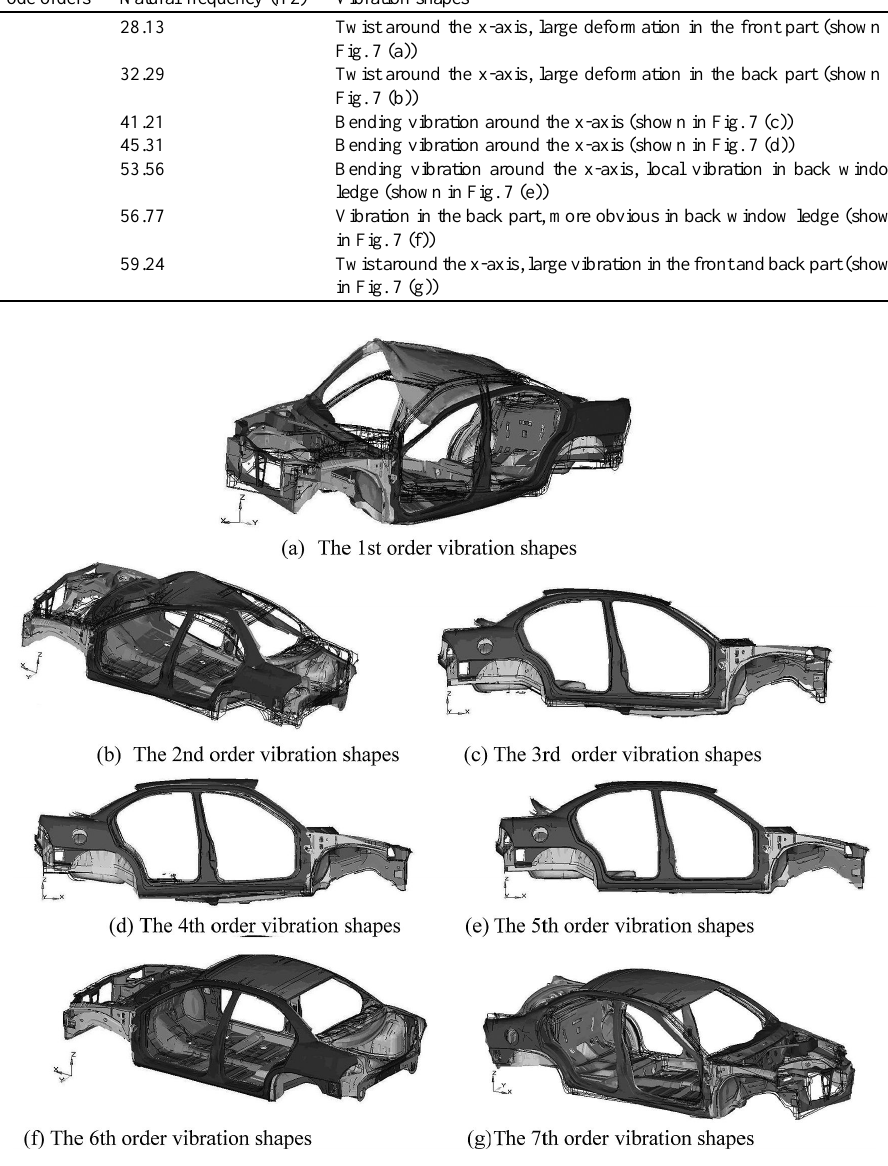
Fig. 7. The 1st – 7th order vibration